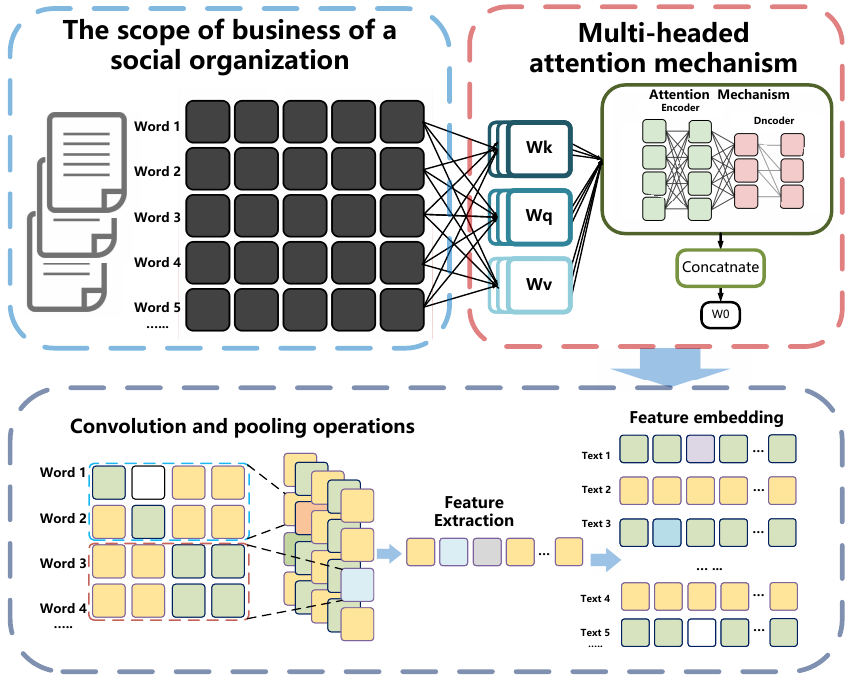
Figure 14. Attention mechanism: natural language